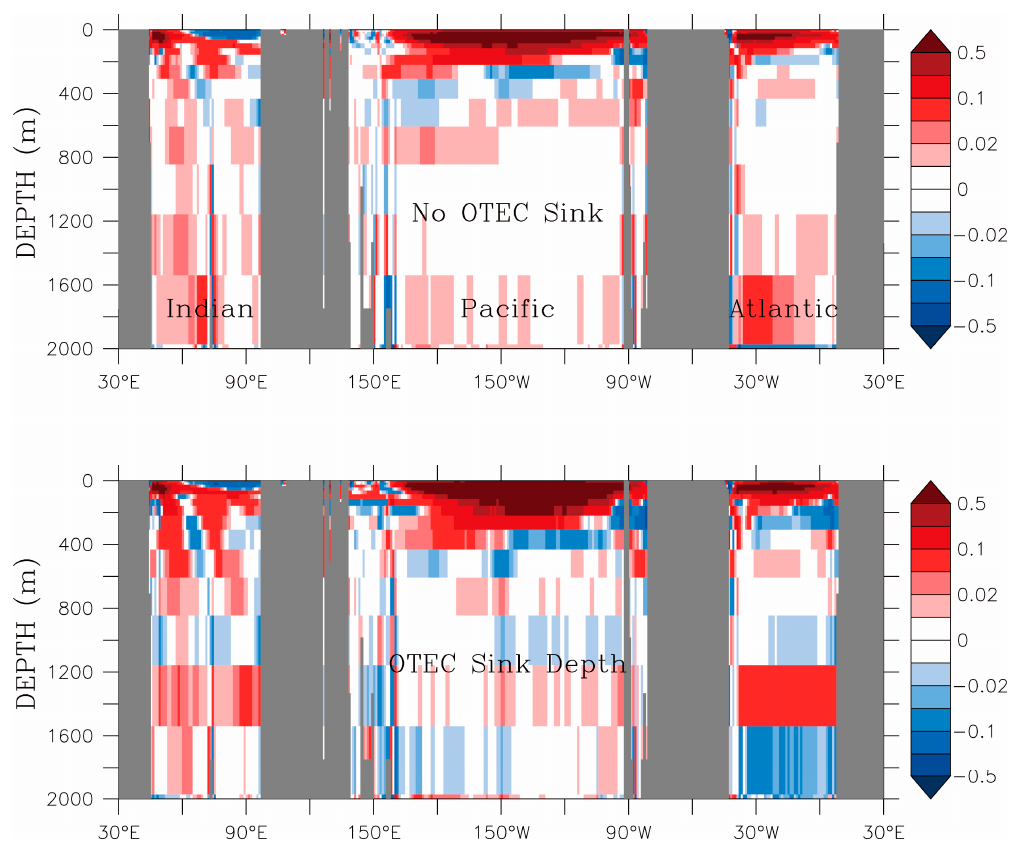
Figure 9. Vertical velocity (m day − 1 ) averaged over a 4° wide band across the Equator, with OTEC ( W15 , lower ) or without ( CTL , upper ).